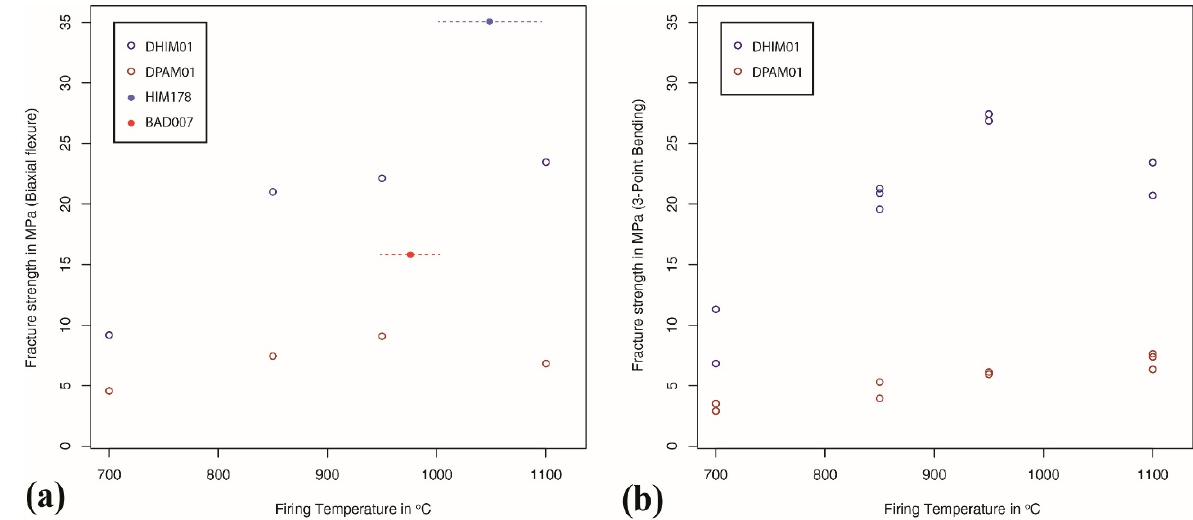
Figure 18. Fracture strength measured in the fired clay specimens and in the two archaeological individuals HIM178 and BAD007: the values are plotted versus firing temperature and the EFT estimated for the two archaeological individuals. The left plot presents the results of the biaxial flexure tests ( a ) and the right plot the results of the 3-point bending tests ( b ). Raw data are available in [106].